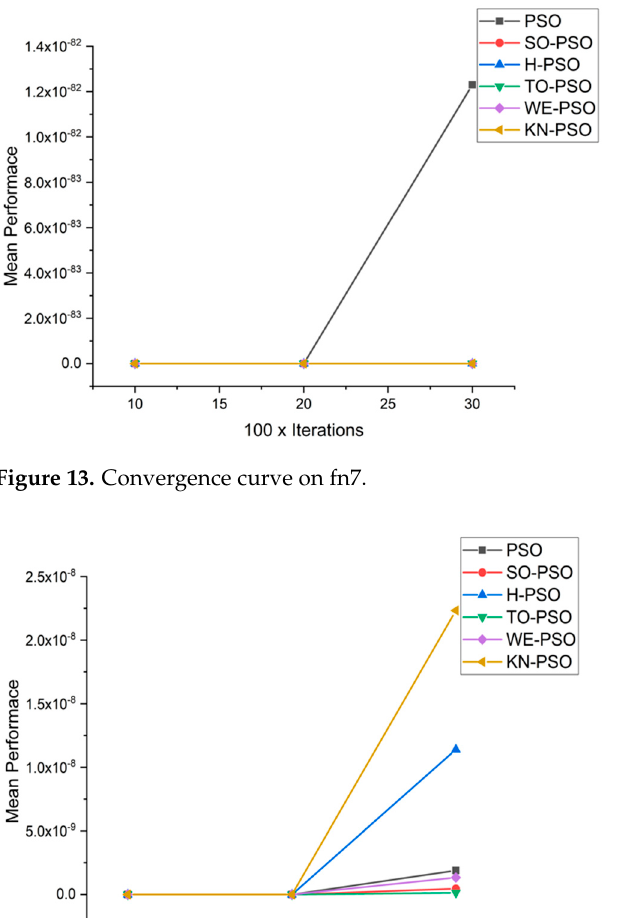
Figure 12. Convergence curve on fn6.